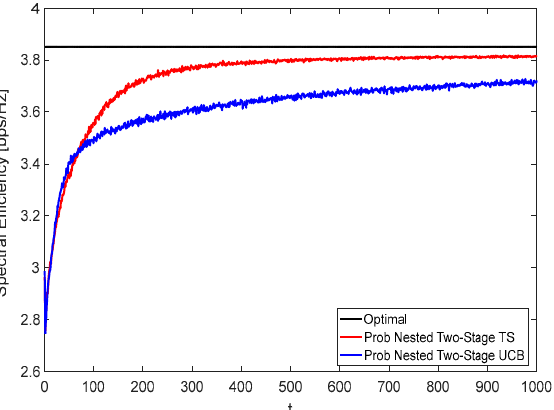
Figure 8. Spectral efficiency convergence at no blockage using K = N = M = 16.